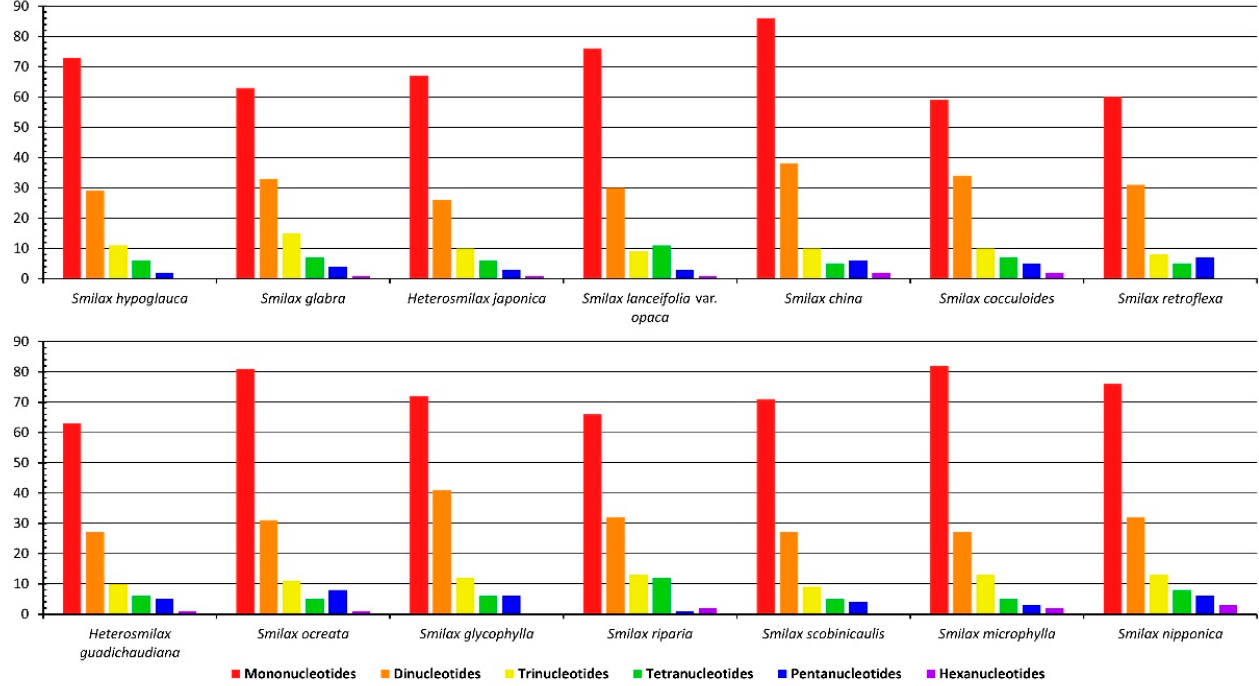
Figure 1. Types of SSRs detected from fourteen Smilacaceae species.